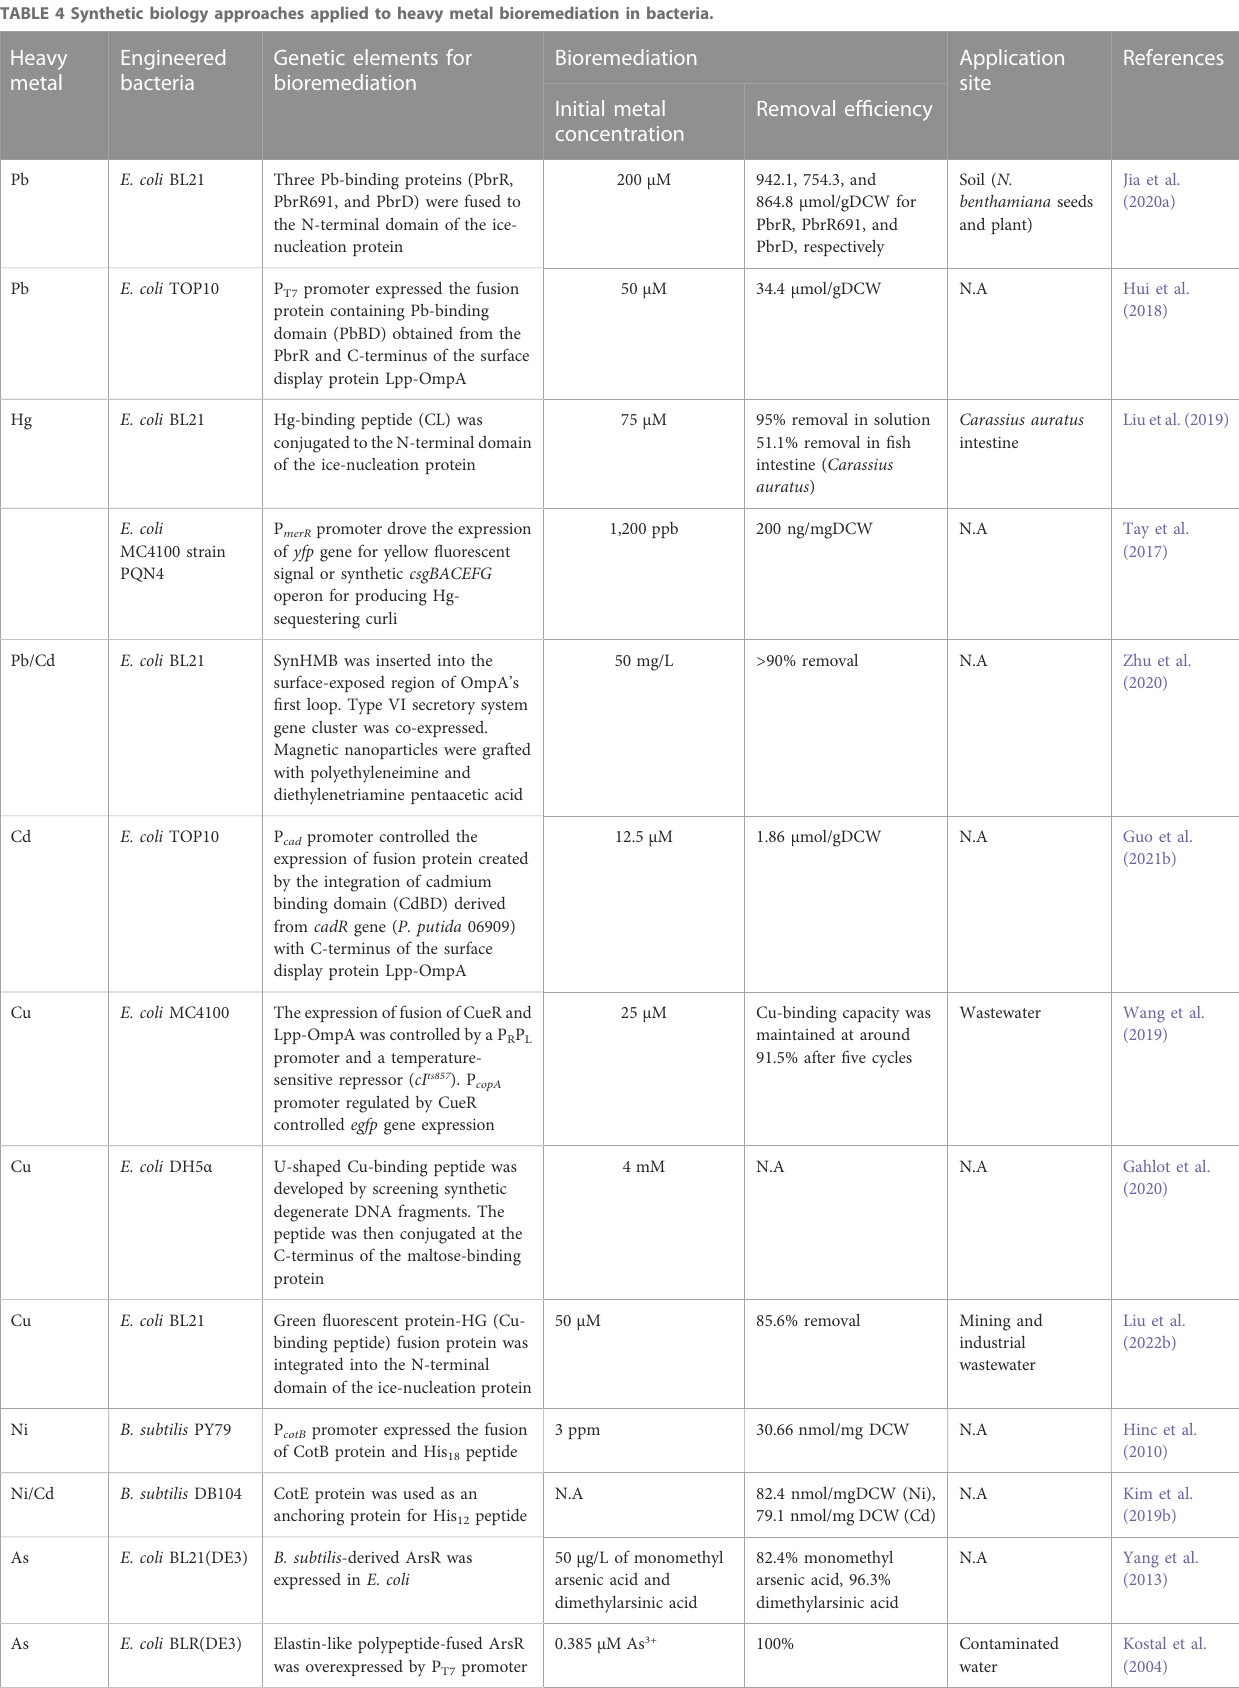
TABLE 4 Synthetic biology approaches applied to heavy metal bioremediation in